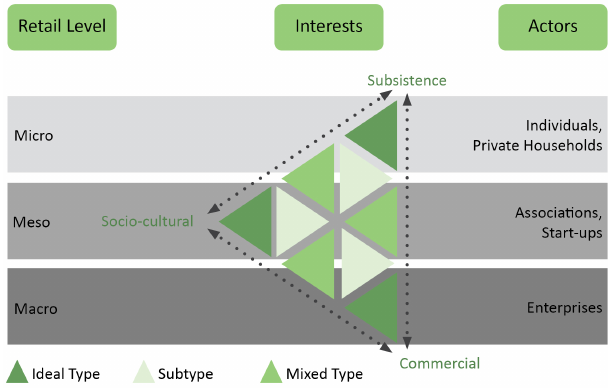
Figure 1. Typology of Urban Agriculture ([2], p. 12; Slightly changed and translated into